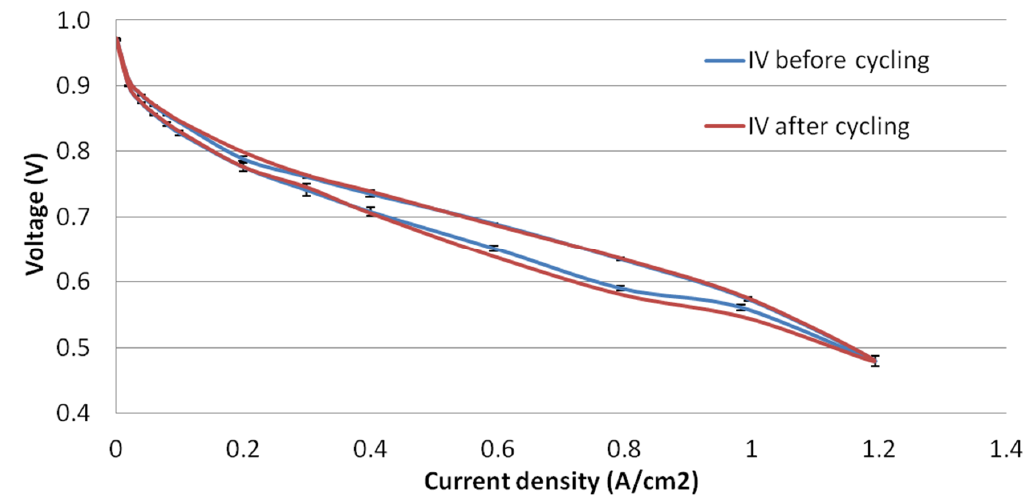
Figure 9. Polarization curves recorded before load cycling and after load cycling. Error bars corresponding to three repetitions are included for each measurement point.